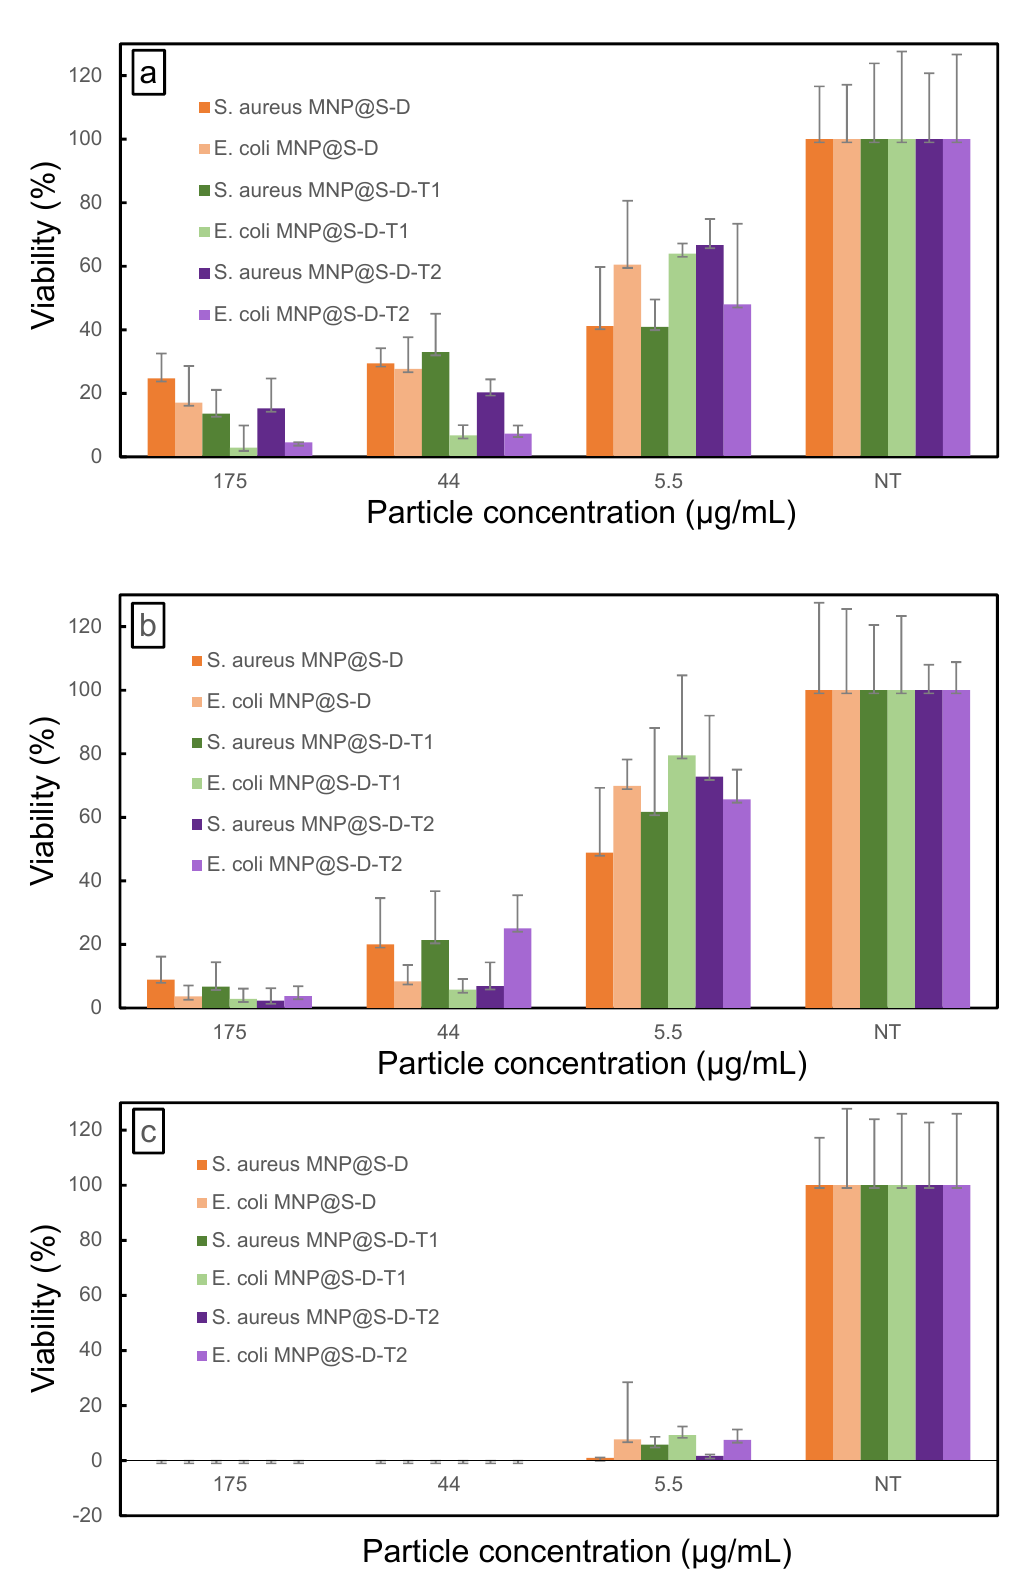
Figure 5. Viability of S. aureus and E. coli treated with MNP@S-D, MNP@S-D-T1, and MNP@S-D-T2 for ( a ) 0, ( b ) 1, and ( c ) 4 h. Culture without any treatment (NT) served as a negative control. Data are expressed as mean ± standard deviation of bacterial viability relative to control in three independent experiments. The results denoted significant differences at p < 0.001 (two-way ANOVA with Bonferroni’s test).